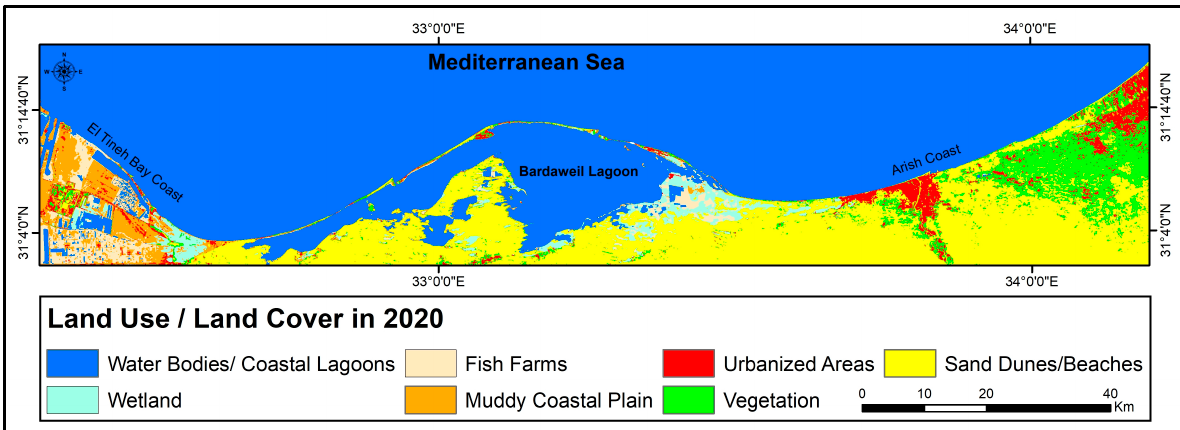
Figure 2. Supervised classification of land use/cover of study area derived from 2020 Landsat-8.